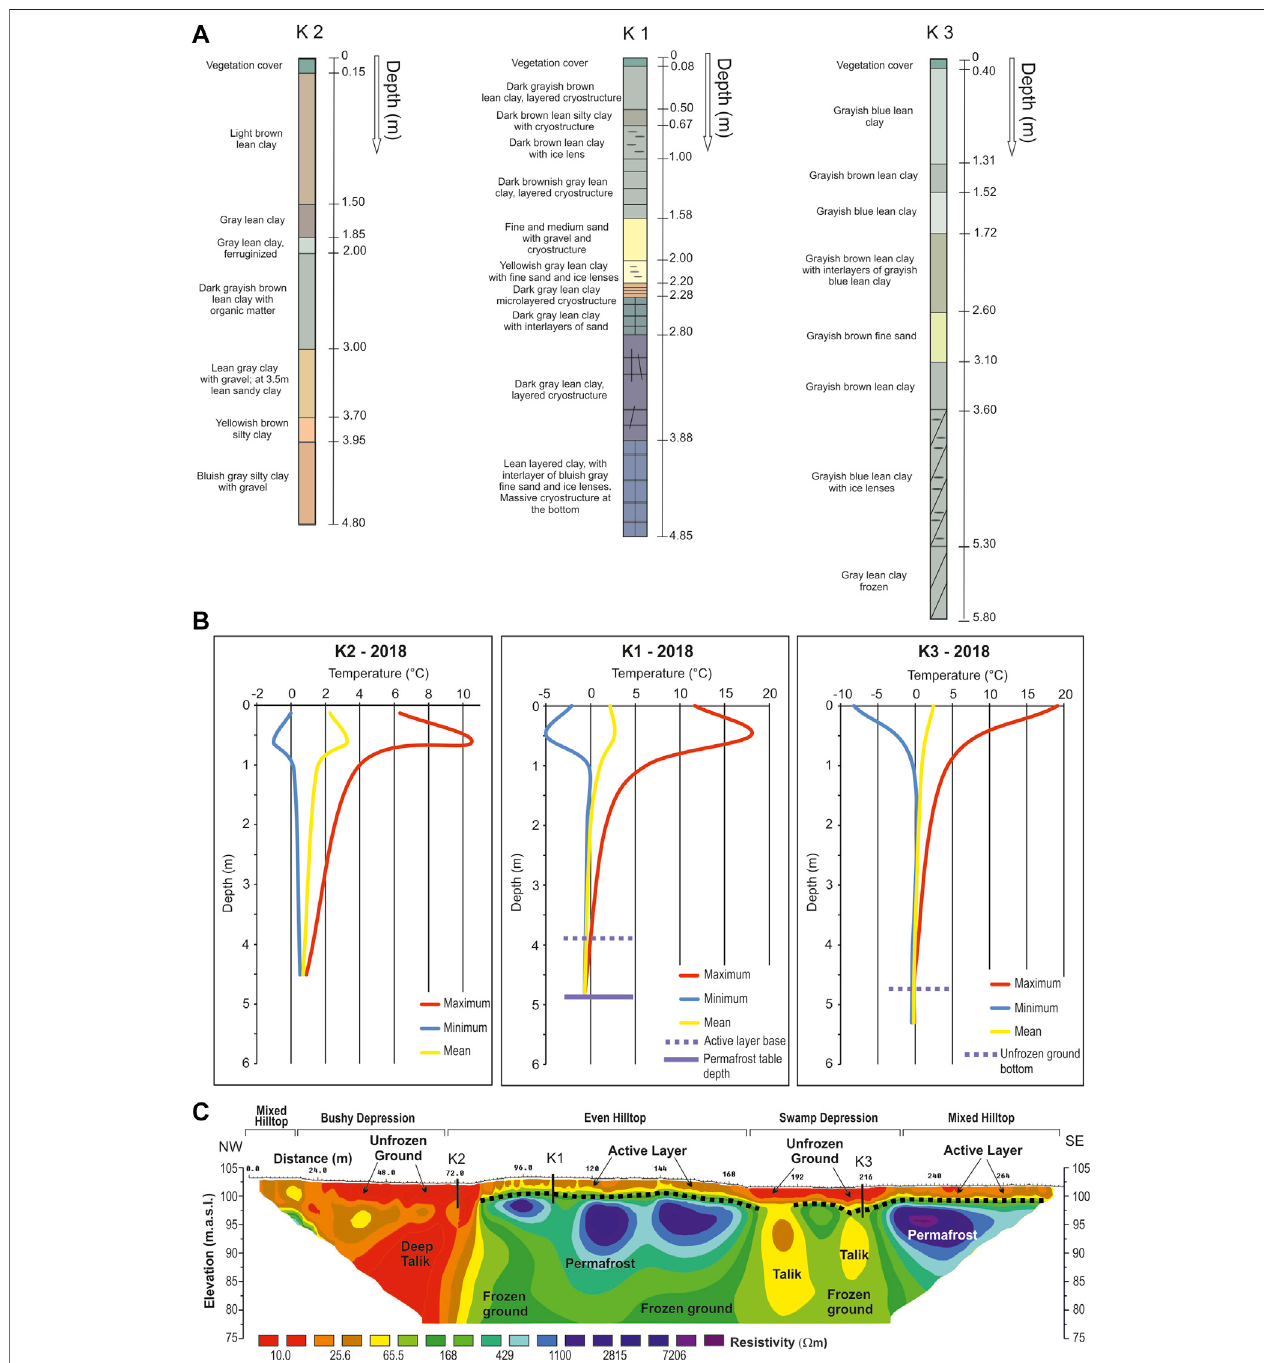
FIGURE6|(A) lithologicaland geocryologicalcore analysisofboreholes K1, K2, and K3(data from Budantsevaet al., 2015;Voytenko et al., 2017). (B) maximum, minimum,andmeantemperature curvesoftheyear2018,wheretheunfrozengroundbottom,theactive layerbottom, andthepermafrosttable depthareindicated. (C) interpretation of the ERT2018 resistivity section (modi fi ed from Tananaev et al., 2021), crossing boreholes K1, K2, and K3. The interpretation of the active layer and unfrozen ground bottom (black dashed line), marked by the resistivity value of 100 Ω m, is in agreement with the core analysis and with the temperature pro fi les at K1 and K3. Wide temperature fl uctuations occur in the active layer, characterized by low resistivity values ( ρ < 100 Ω m). A deep talik is present in the NW sector, explaining the unusual trend in the temperature pro fi le of the K2 borehole. Two taliks enclosed in the frozen ground are present beneath the swamp depression zone, between K1 and K3 ( ρ < 80 Ω m), covered by a 3 m thick unfrozen ground layer. One of the two taliks is open to the surface.